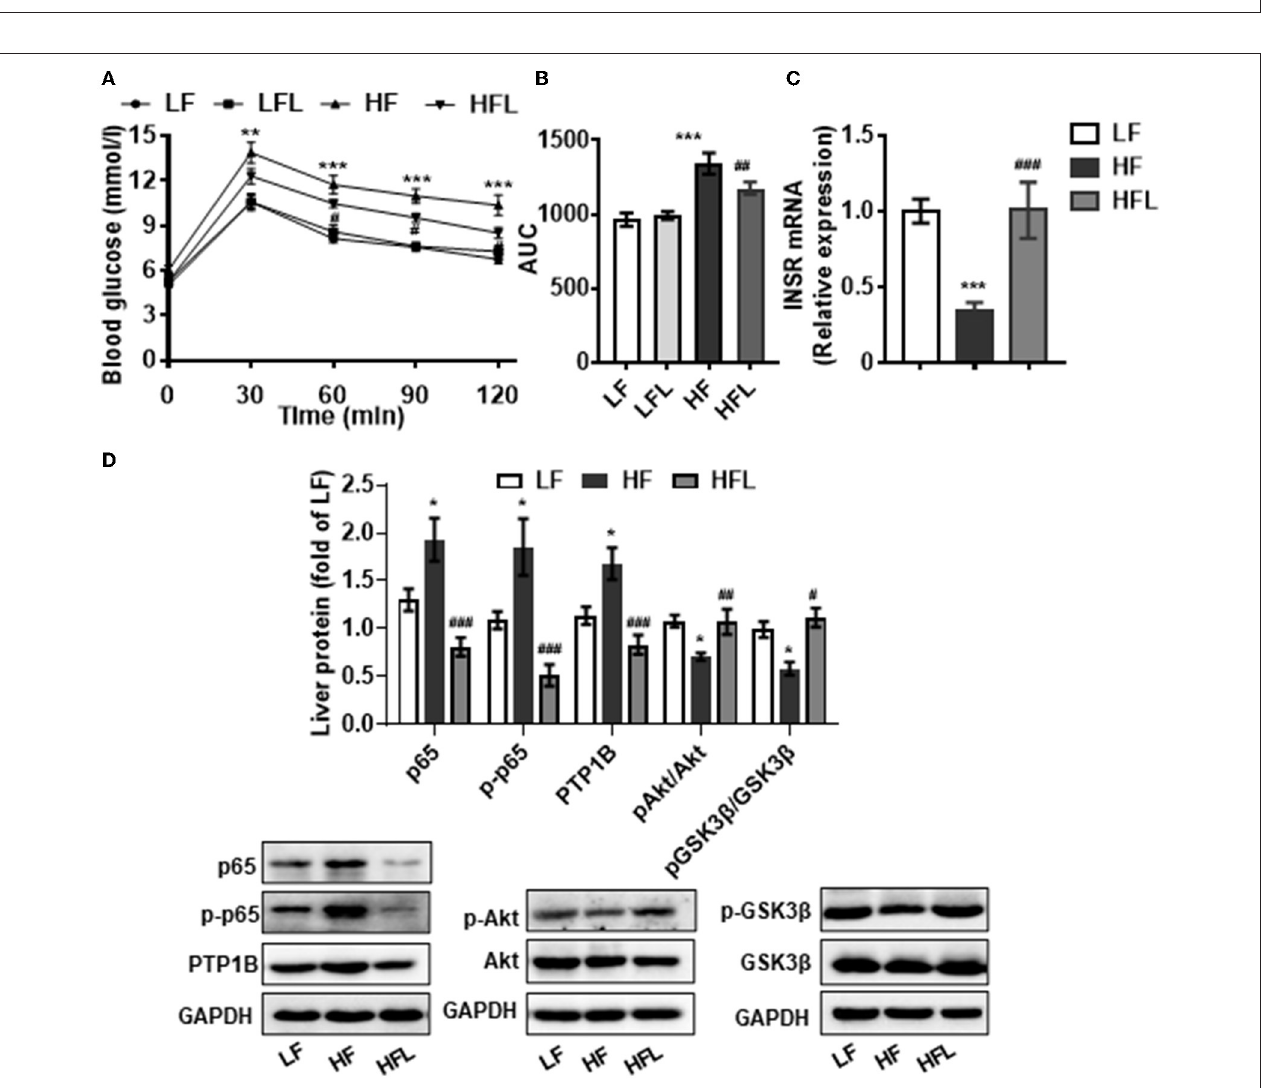
FIGURE 5 | Lentinan improved glucose intolerance and NF κ B-PTP1B-Akt-GSK3 β signaling pathway in the liver of HF mice. (A) Blood glucose levels during GTT performed on week 13 and (B) area under the curve (AUC). (C) Hepatic INSR mRNA levels. (D) Protein levels of p65, p-p65, PTP1B, p-Akt/Akt, and p-GSK3 β /GSK3 β in liver tissues. Values are means ± SEM ( n = 6). * p < 0.05, ** p < 0.01, *** p < 0.001 vs. LF mice; # p < 0.05, ## p < 0.01, ### p < 0.001 vs. HF